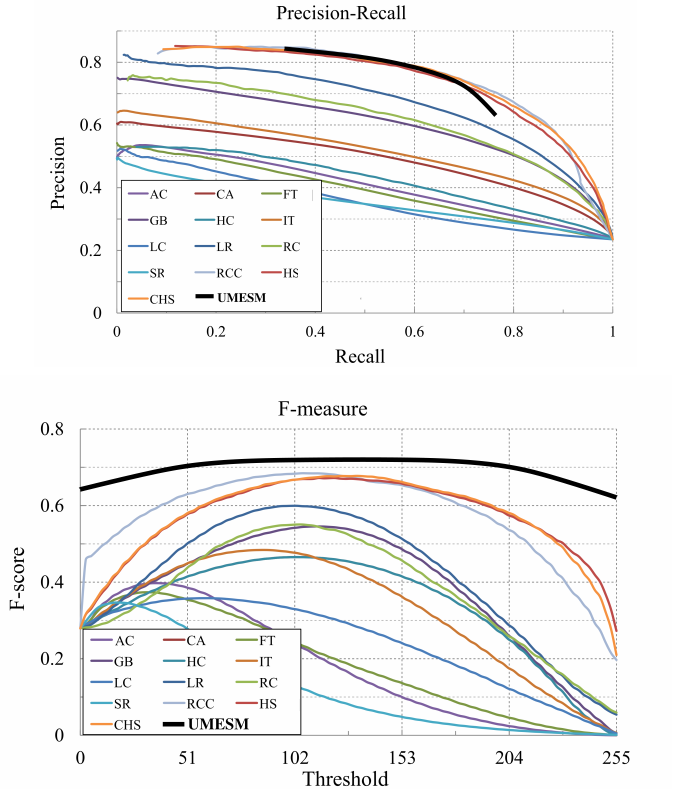
Figure 4. Quantitative comparison on ECSSD. From left to right: precision–recall curve for each possible threshold (within the range [ 0,255 ] ) and F β -measure (see Equation (14) and [68]) with β 2 = 0.3 as a function of the